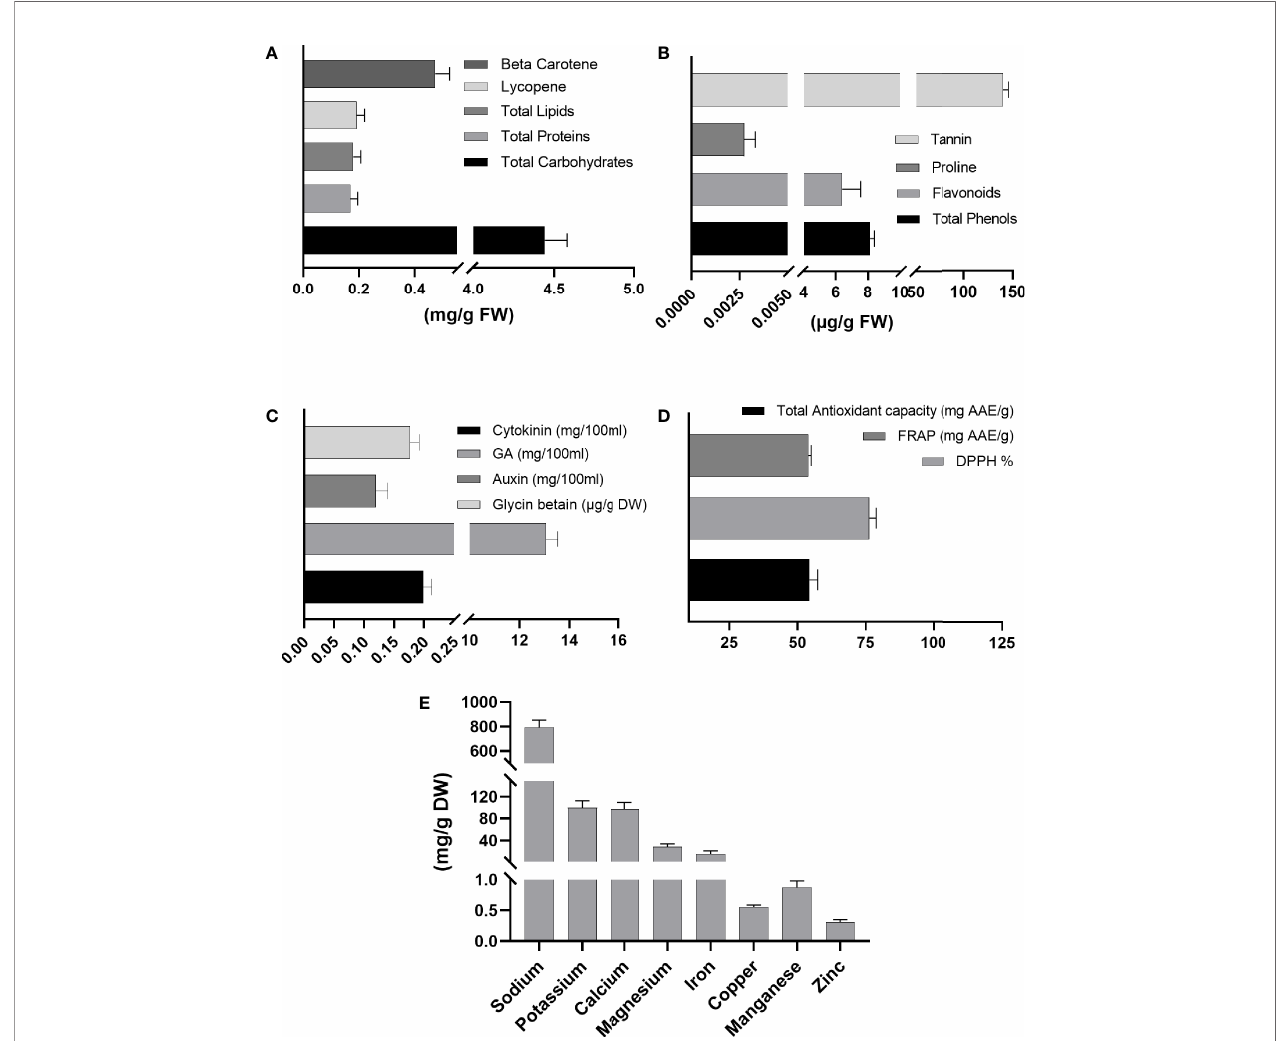
FIGURE 1 | Chemical composition of Sargassum wightii. (A) Primary metabolites; (B) secondary metabolites; (C) hormonal content; (D) antioxidant capacity; (E) ionic analysis. Quantitative data represent means ± SD ( n = 7). FW, fresh weight; DW, dry